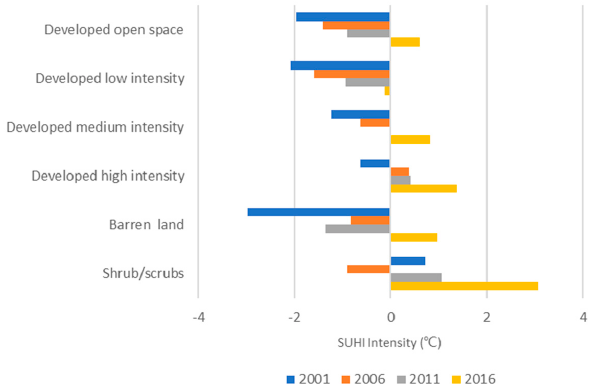
Figure 9. Mean surface urban heat island (SUHI) intensity in each LULC type.